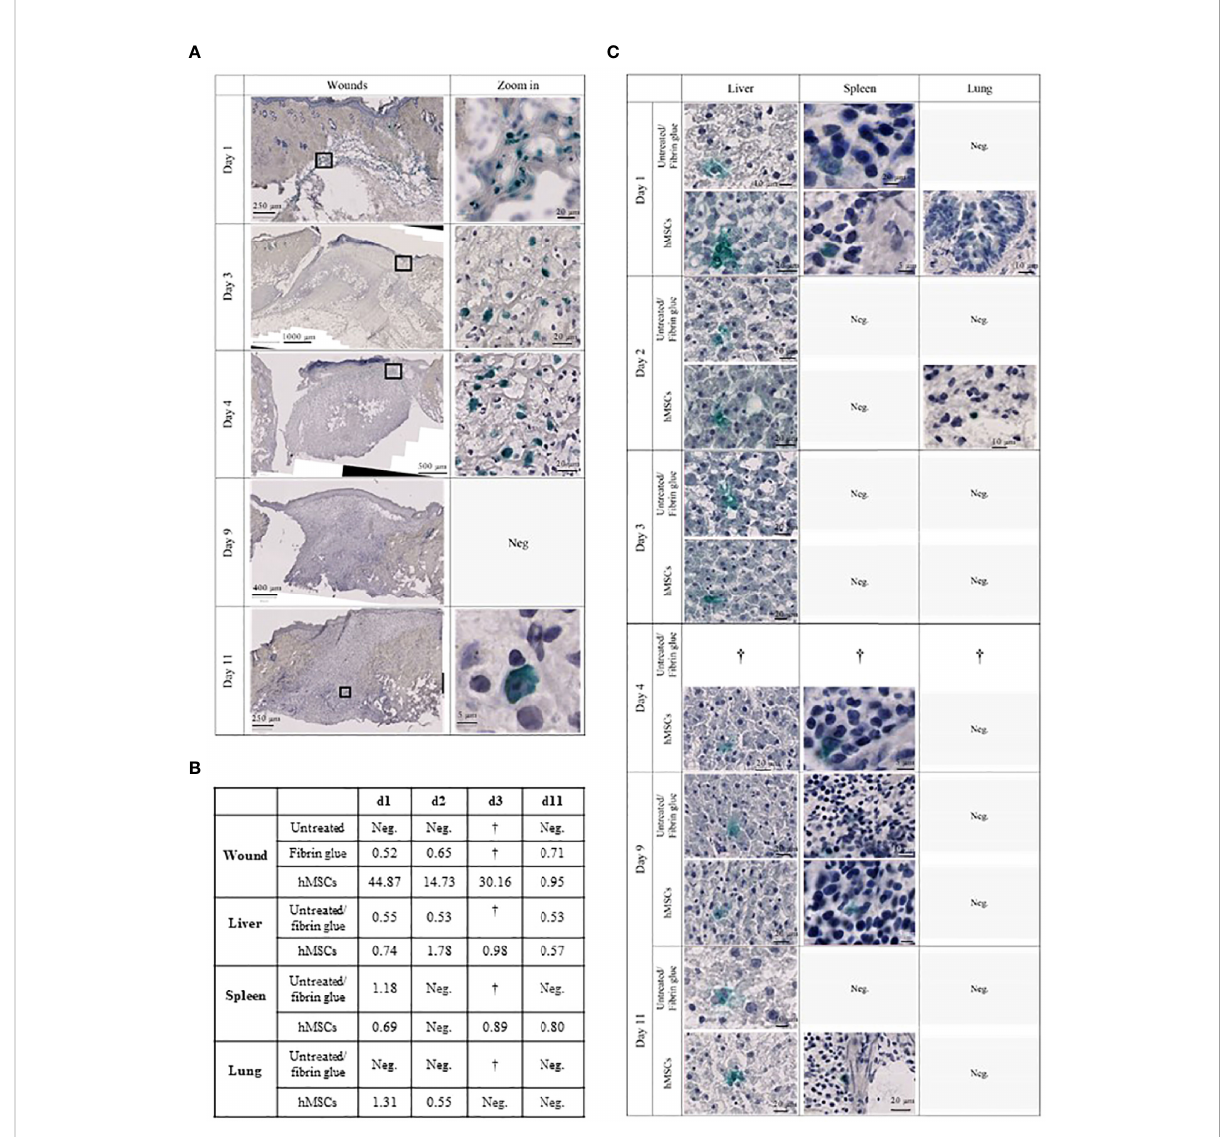
FIGURE 8 hMSCs are only transiently detectable in wounds. (A) Human Ku80-Histogreen staining in wound cross-sections. Left: Cross section of the entire wound. Right: Zoom on hKu80-positive cells. On day 1, wound edges with fi brin glue containing hMSCs located under the intact dermis are shown. Day 3 and 4 after hMSCs application, intact hMSCs were located in the fi brin glue top of the wound. Despite detection of human DNA in the wounds by dPCR on day 9, no hKu80 signal was detected in the histological sections. On day 11, very few hKu80-positive cells were found in the basal part of the wounds. (B) dPCR results of human DNA in rat wounds and organs. A value of ≥ 0.5 copies/µl was taken as positive result. (C) hKu80 expression in cryosections of analyzed organs: representative microphotographs are shown for samples where human cells were detected; no microphotographs are shown for negative